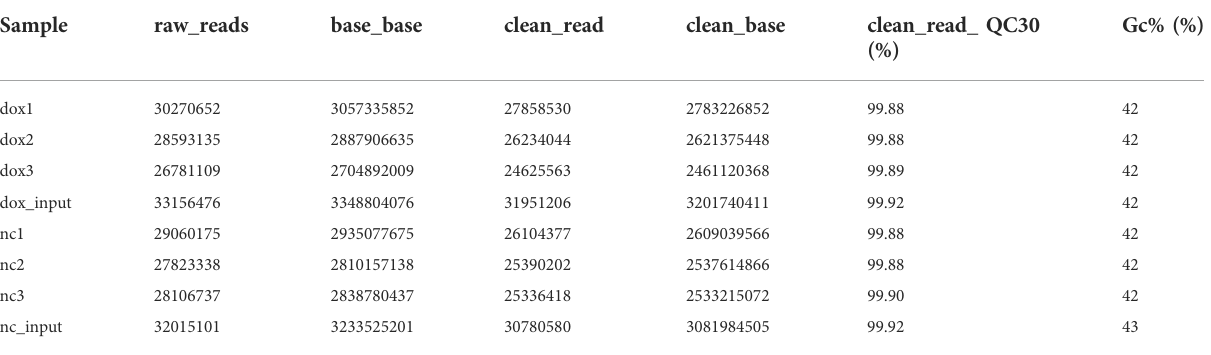
TABLE 1 Quality of sequencing output data.